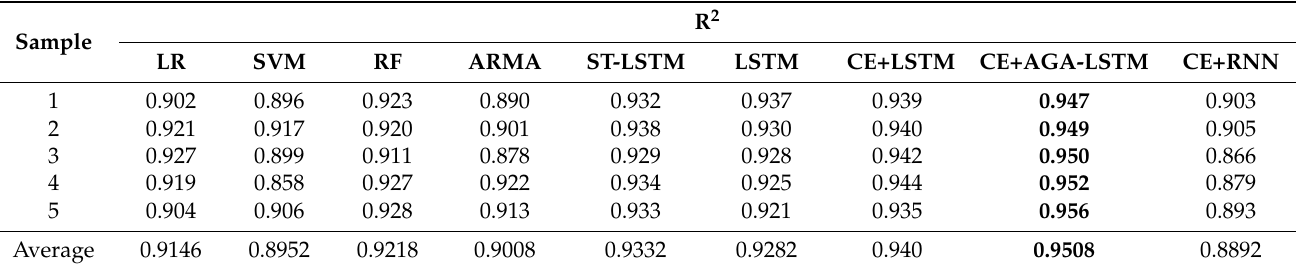
Table 7. Mean Values of R 2 in five Experiments.